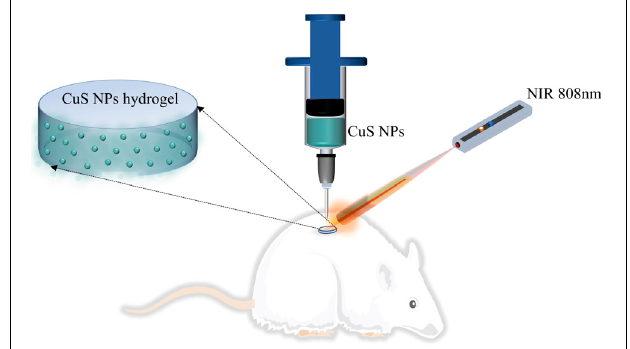
FIGURE 1 | Schematic presentation of CuS NPs-incorporated HA injectable hydrogel for wound healing.